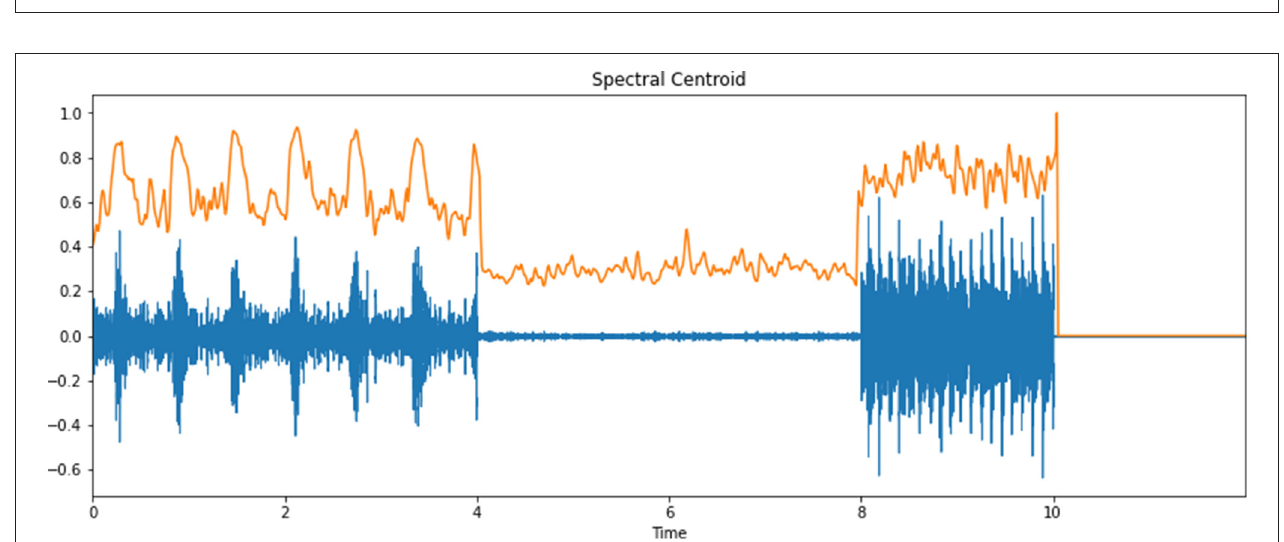
FIGURE 5 | Spectral roll-off of an infant cry’s audio signal.